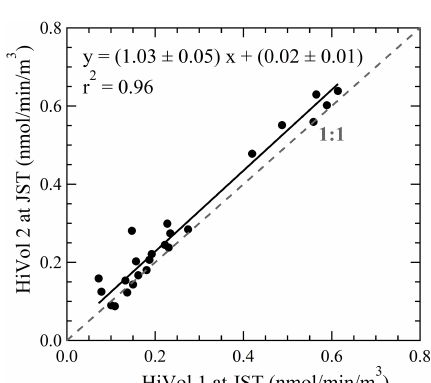
Table 2. Performance of the automated system as assessed by consistency of DTT consumption rate for blanks and positive controls. Sample Sample size Standard deviation, nmol/min DI blank Field blank extracted in DI water Positive controls (9,10-phenanthrenequinone)